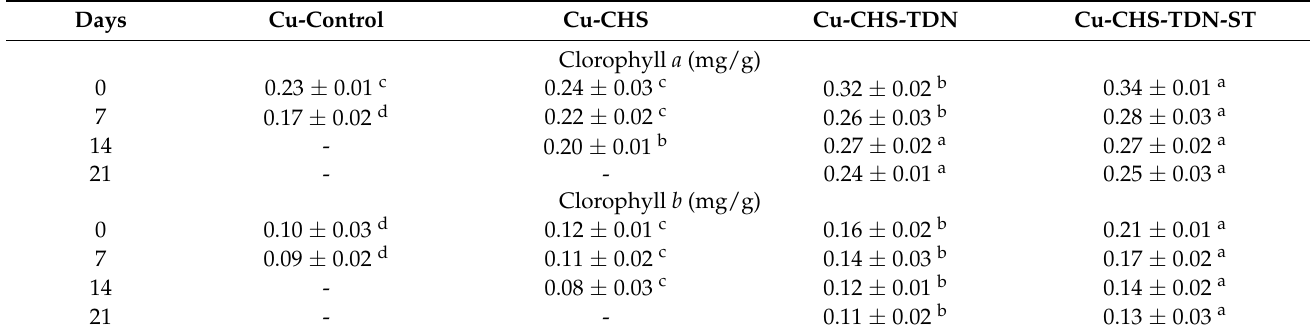
Table 1. Effect of coating treatments on clorophyll contents.